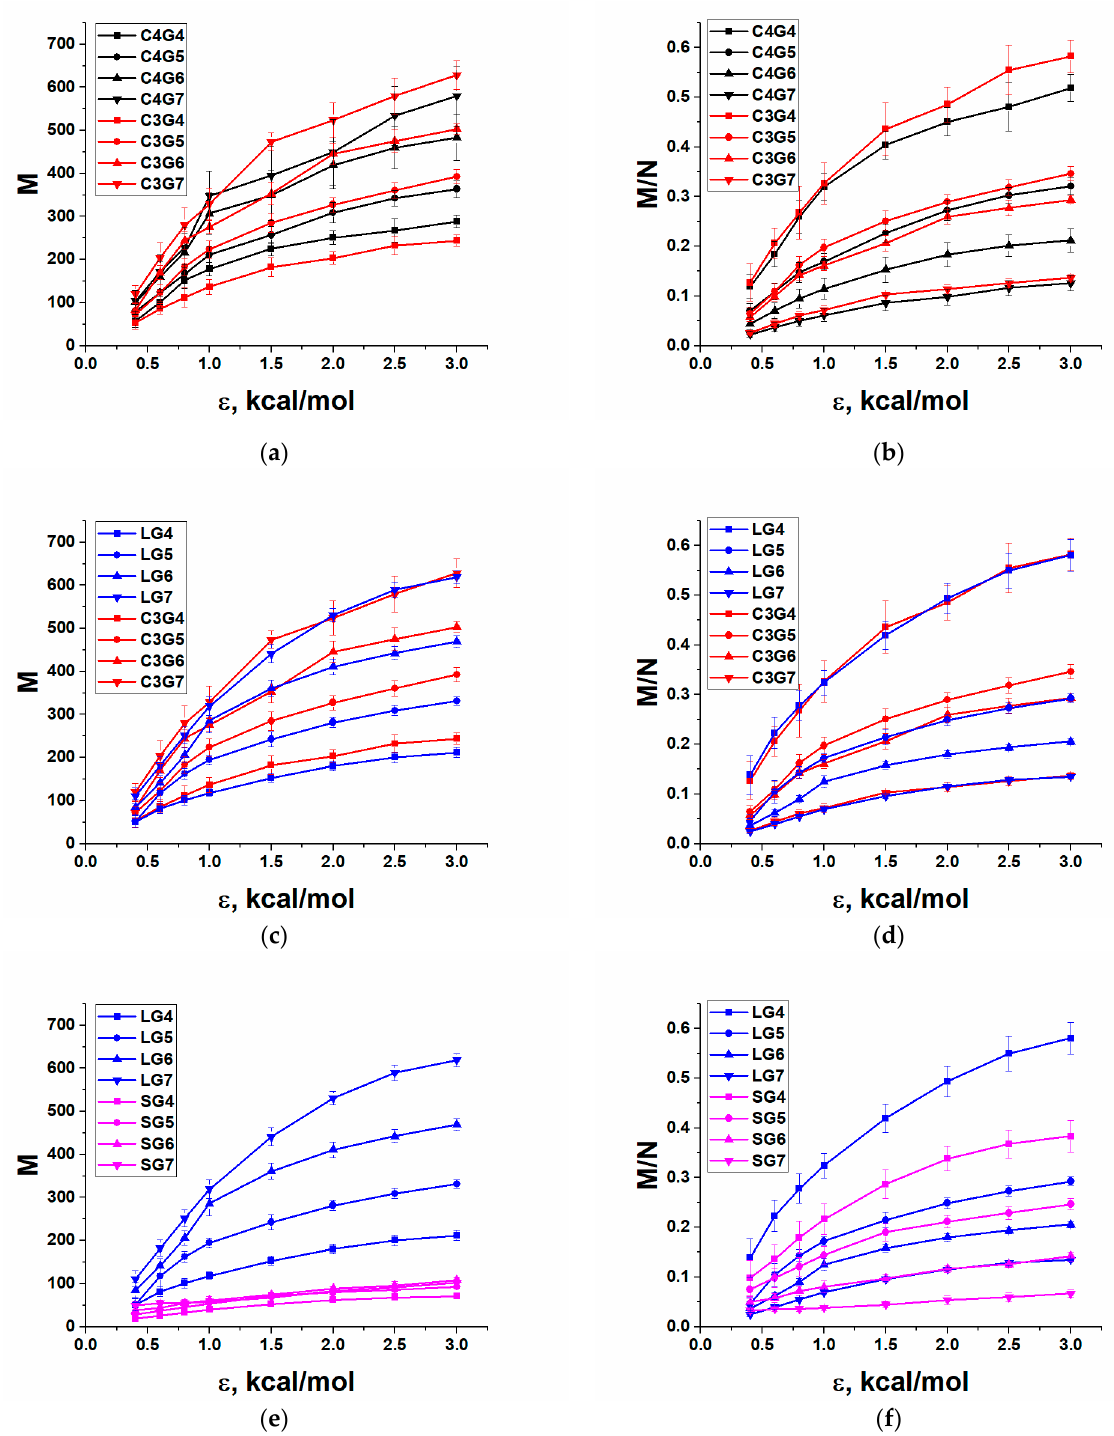
Figure 3. Dependences of the absolute, M, ( a , c , e ) and relative, M/N, ( b , d , f ) number of the adsorbed atoms on the adsorption energy parameter ε for the carbosilane and the siloxane dendrimers of various generations. The dendrimer types are indicated in figure legends.